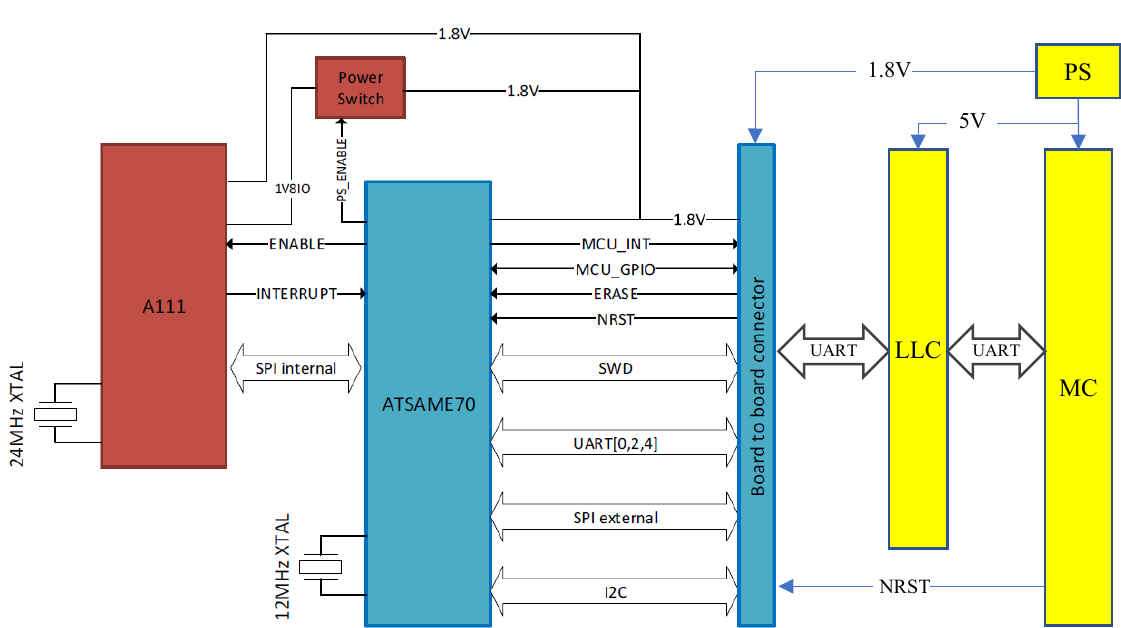
Fig. 11. PCR sensor module-based car counting system block